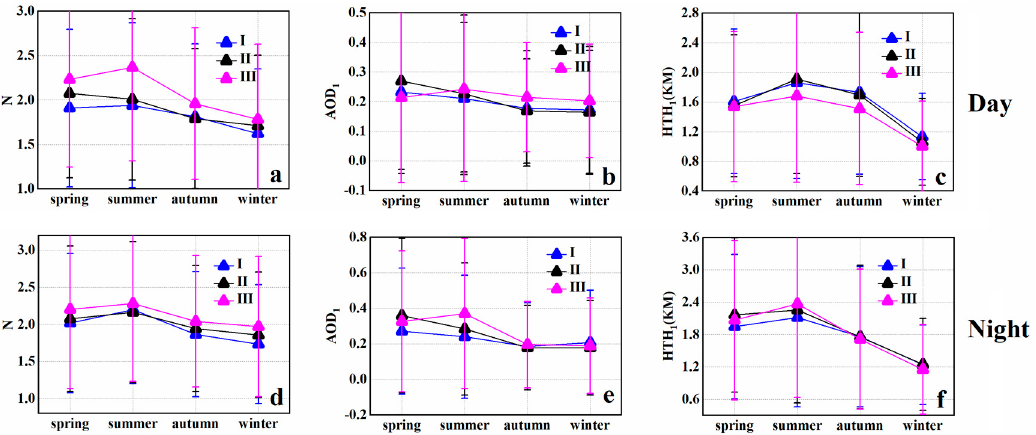
Figure 15. Seasonal variation in the optical and physical properties of aerosol layer over Saudi (regions I, II, and III) from 2007 to 2019. ( a , d ) represent N, ( b , e ) represent AOD 1 , and ( c , f ) represent HTH 1 .